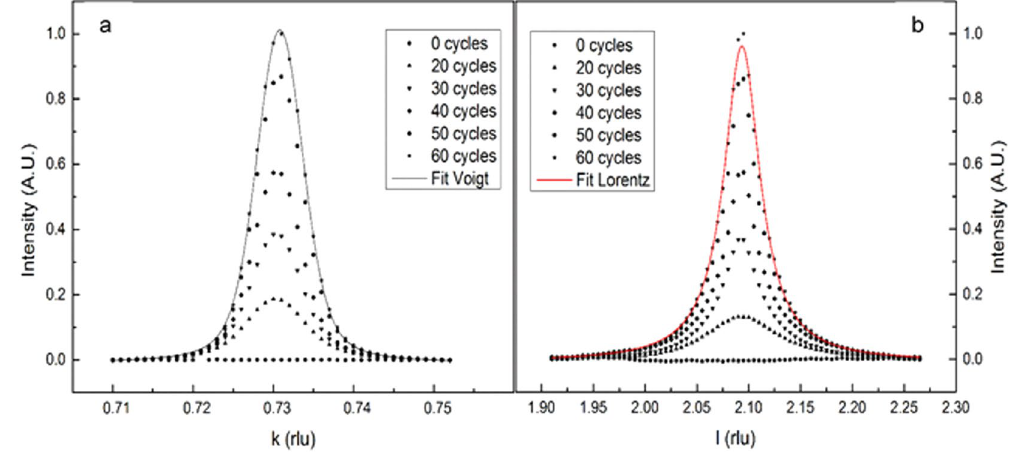
Figure 2. Scans along (h, h, 2.1) ( a ) and along (0.73, 0.73, l) ( b ) at different stages of